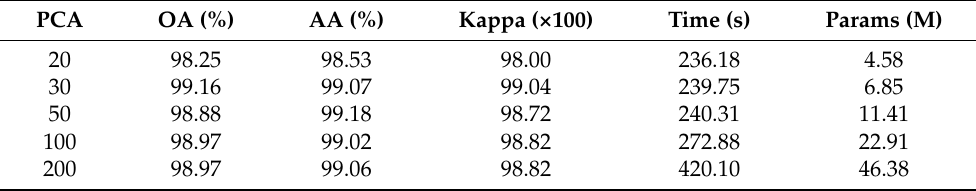
Table 3. Experimental results with different PCA coefficients on the IP dataset.